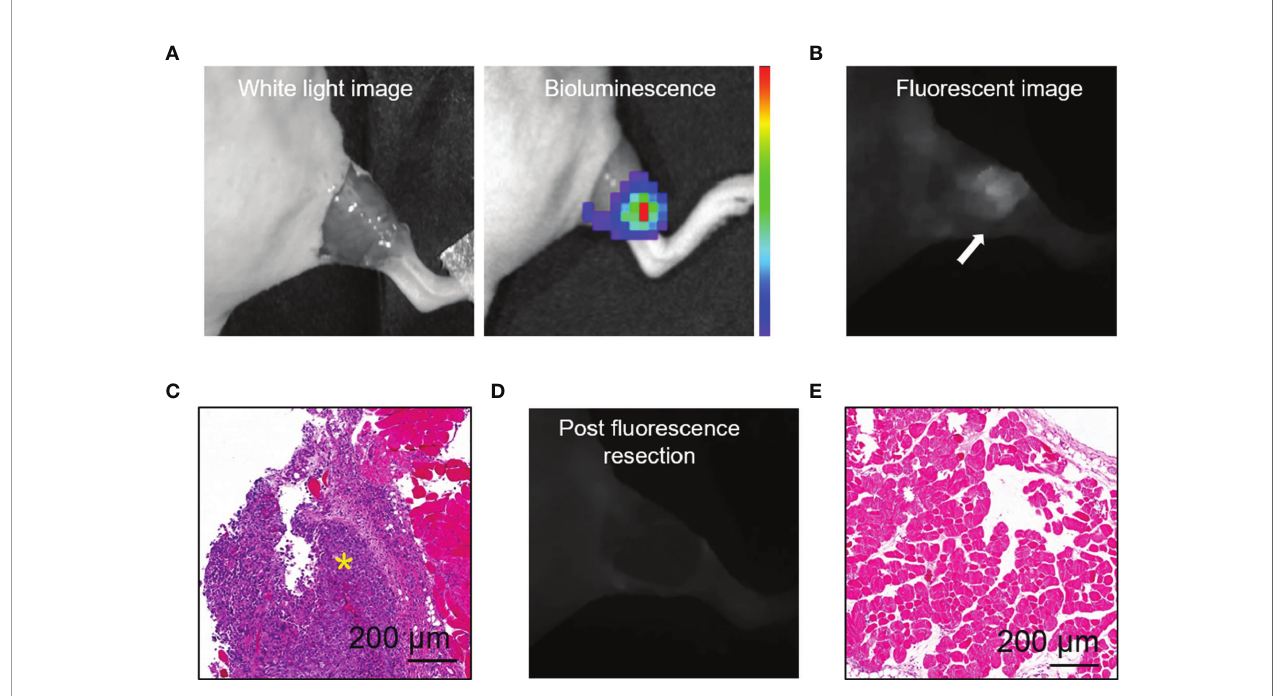
FIGURE 4 | HSA-ICG enabled fl uorescence-guided resection of residual lesions in MDA-MB-231-luc tumor-bearing mice. (A) Establishment of the model of positive-margin resection. The residual cancer was not clearly seen by the unaided eye (left), and was con fi rmed by bioluminescence imaging (right). (B) Fluorescence image of the tumor bed showed residual cancer undetectable by white light. (C) Hematoxylin and eosin staining of the resected tissue from (B) . A yellow asterisk marks the tumor. (D) Fluorescent image of the tumor bed following fl uorescence-guided resection, indicating the absence of fl uorescence signal. (E) Tissues on the tumor bed from (D) were collected and examined histologically to con fi rm the absence of residual